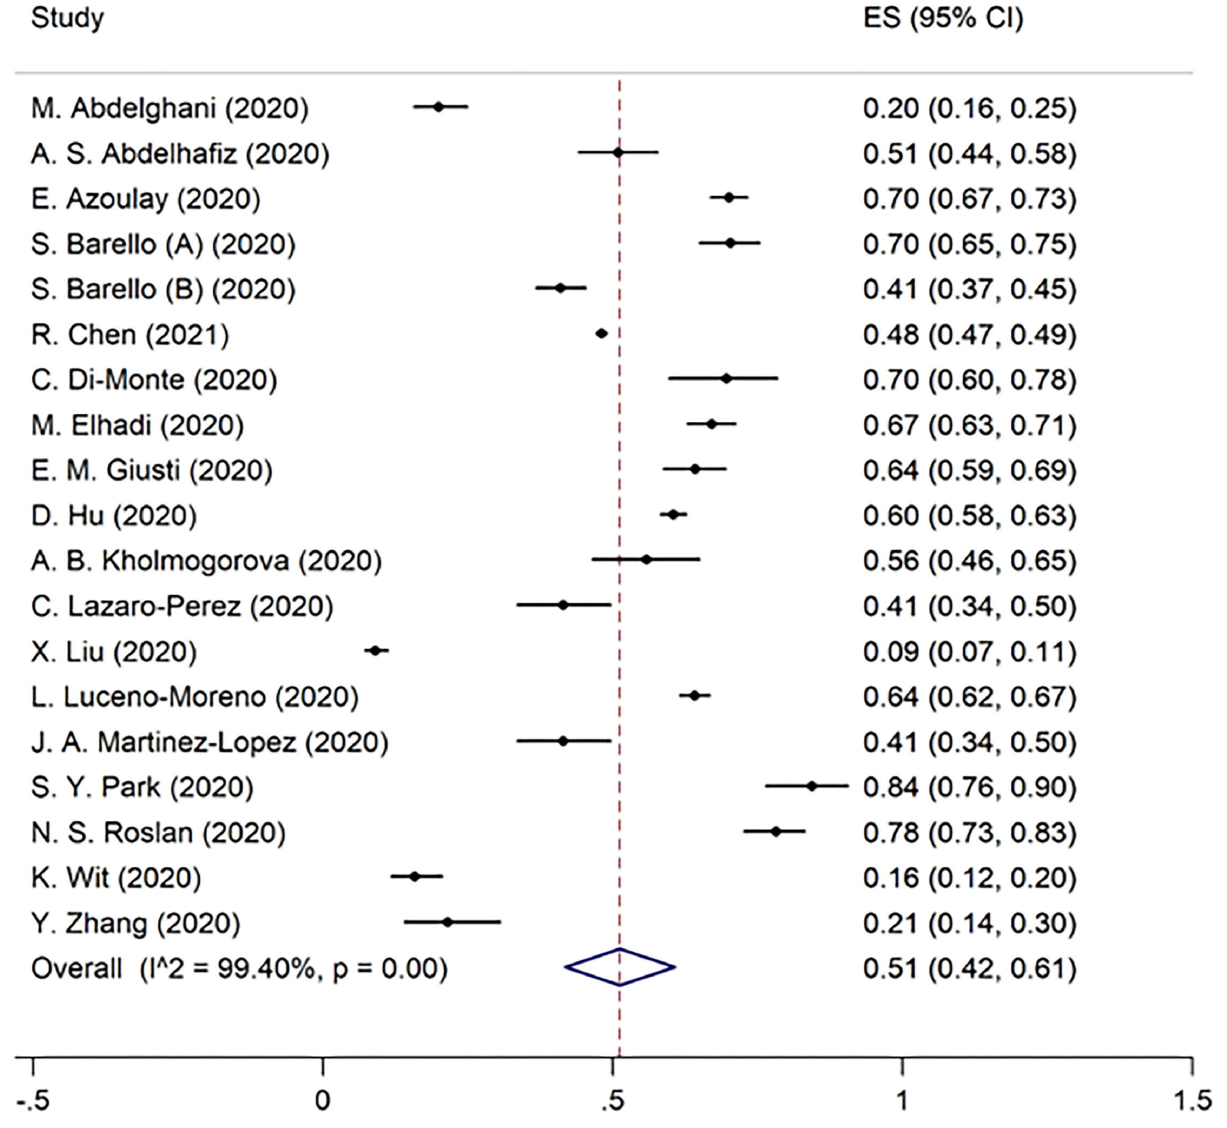
FIGURE 5 | The pooled prevalence of lack of personal accomplishment in included